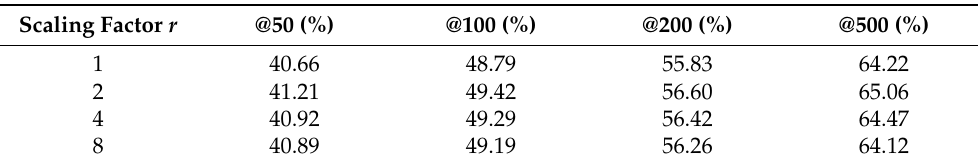
Table 4. Analysis of hyperparameter settings on THUMOS14 dataset, measured by AR@AN. r is the channel scaling factor in TBG.